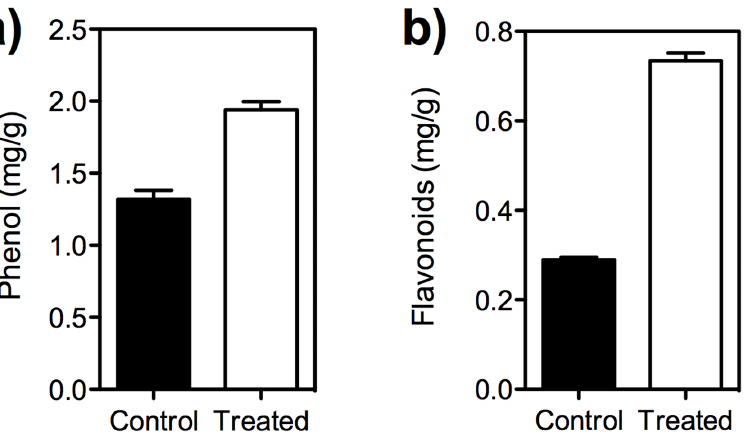
Fig 7. Effect of SA on the total phenol and flavonoids content. (a) Total phenols; (b) Total flavonoids. The total phenol and flavonoid levels were increased in the 2mM SA treated fruit when compared to the control fruit (unpaired t test, t = 7.38, df = 4, P = 0.0009 [phenols], t = 24.92, df = 4, P = 0.0001